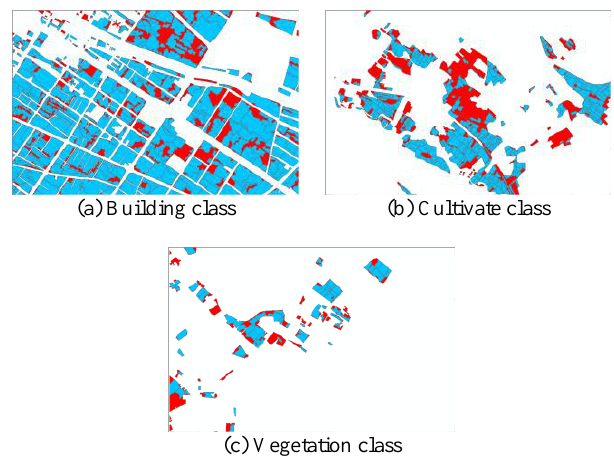
Figure 8. Changed areas. Red segments shows the areas that were changed